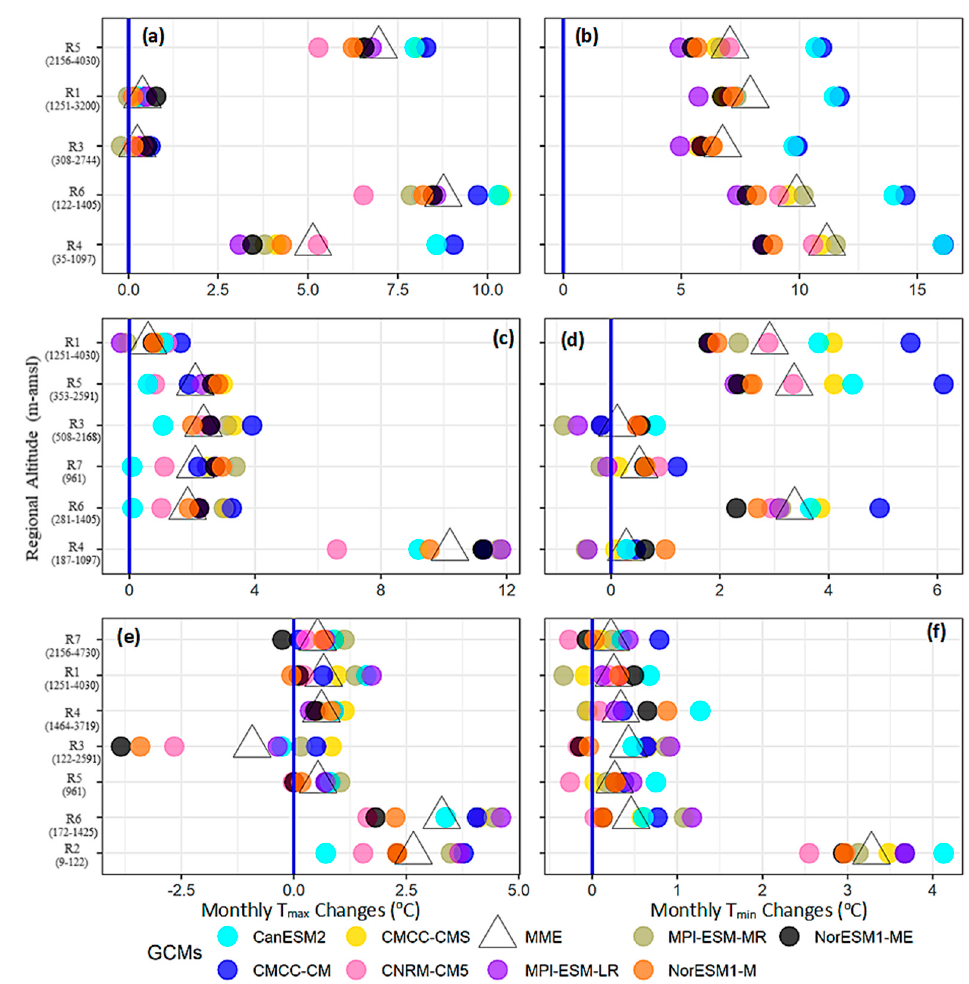
Figure 5. Downscaled (unweighted) seasonal temperature changes ( ◦ C/month) during 2071–2100 compared to 1976–2005 under the RCP8.5 scenario during the basin-wide regionalization experiment. ( a , b ) show the WS changes for T max and T min , respectively. The PMS T max and T min changes are represented by ( c , d ), and corresponding MS changes are shown by panels ( e , f ), respectively. The Y-axis shows the different sub-regions arranged in decreasing altitudinal order from top to bottom and the range of regional altitudes given in parenthesis. The colored circles (triangles) show the individual GCM (MME) median temperature changes. The solid blue line indicates no change.